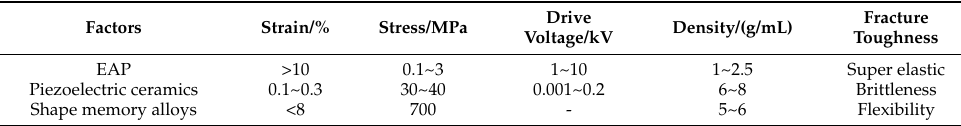
Table 1. Performance comparison of EAP and traditional